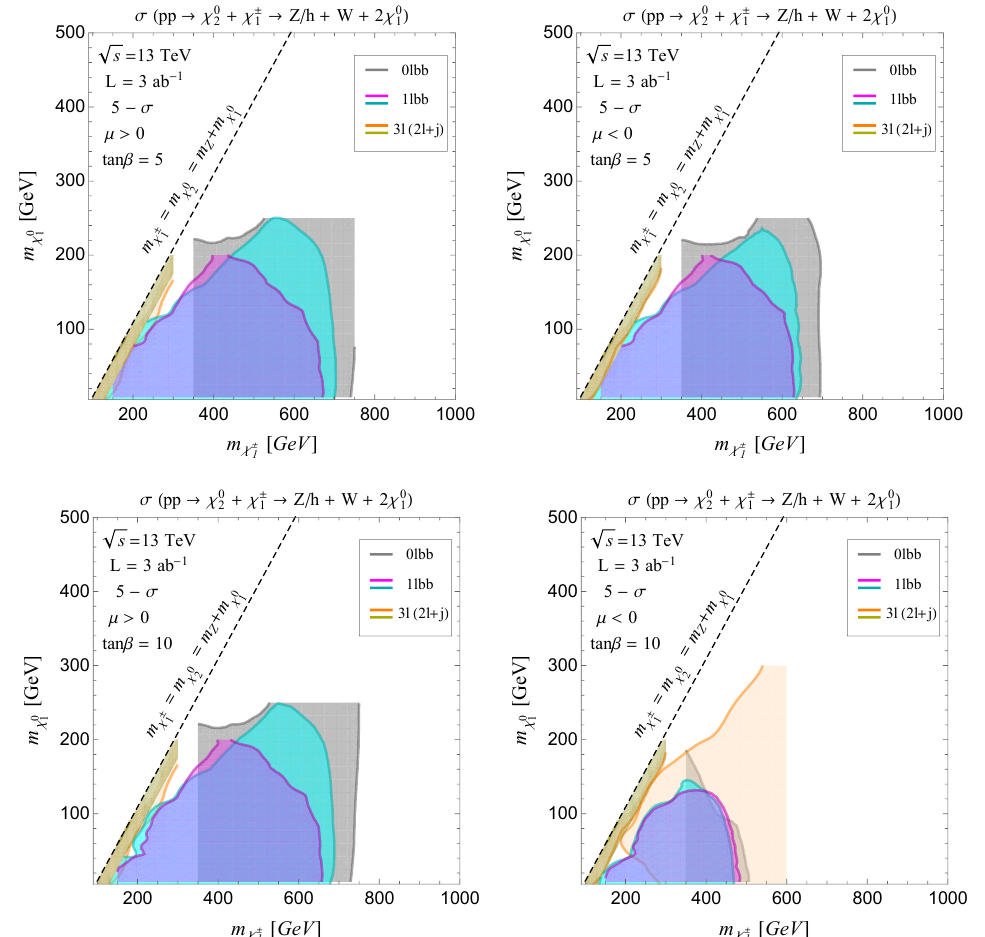
Figure 9 . The future potential on the Bino-Wino scenario projected for 5 σ reach at 3 ab − 1 with M SUSY = | µ | = 2 TeV. The labels are similar to figure